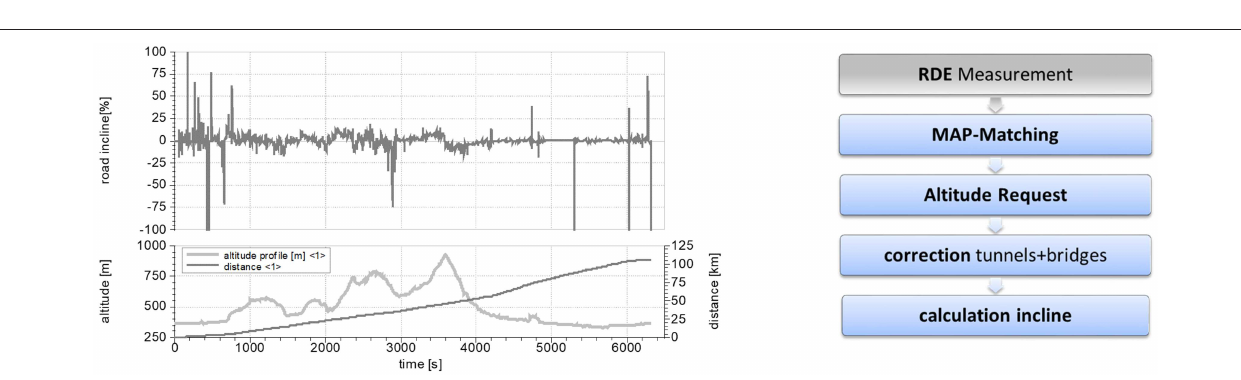
FIGURE 4 | Workflow for incline calculation and calculated road